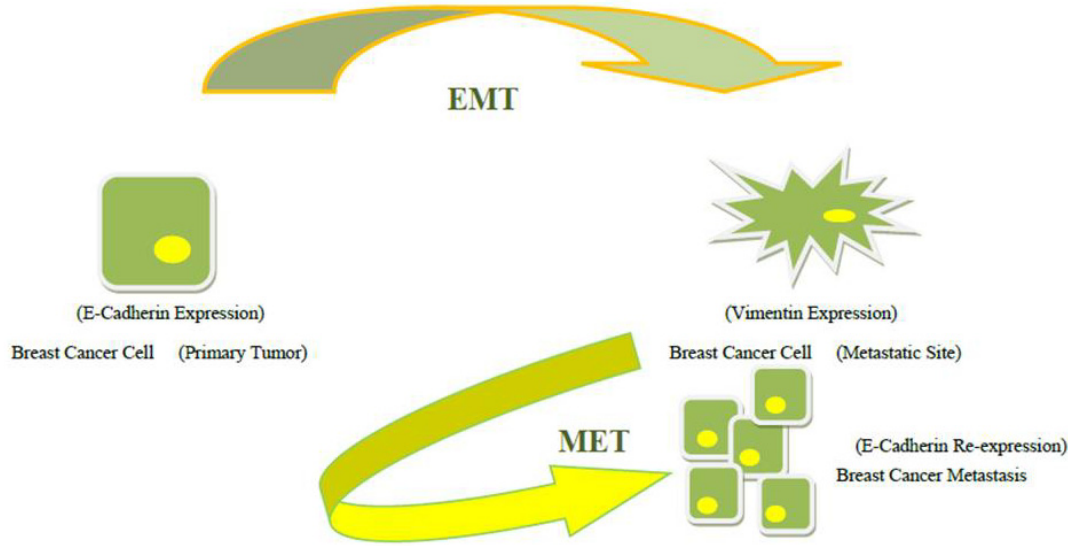
Figure 2. Mesenchymal to epithelial transition